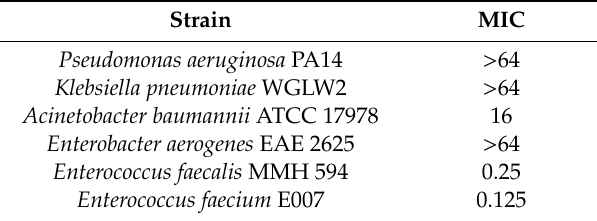
Table 1. Minimum inhibitory concentration ( µ g / mL) of IMD0354 to selected ESKAPE pathogens. Strain